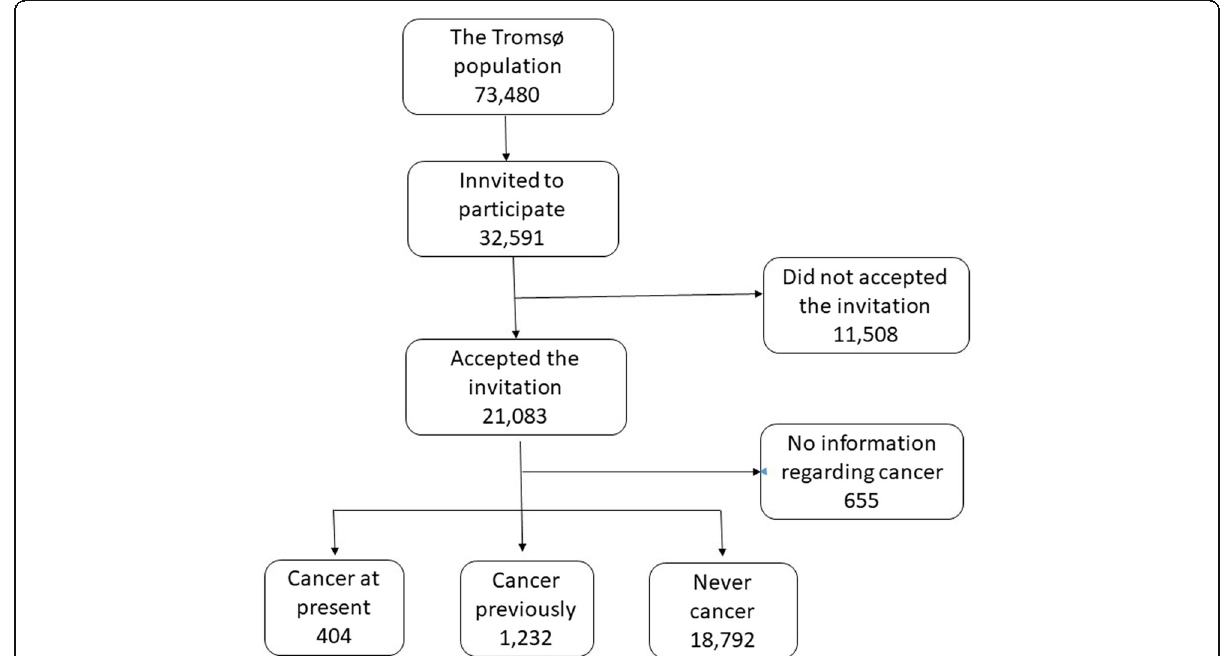
Fig. 1 Flow chart of the study